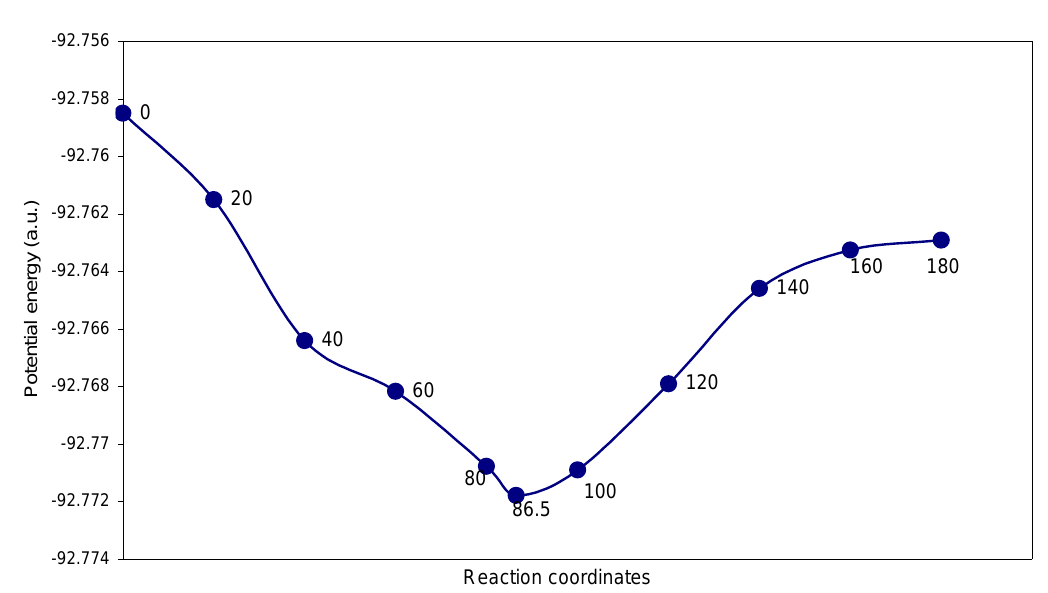
Table 8: the optimized geometric parameters and total energy as a function of torsional angles; The potential energy diagram of the molecule is the Figure 8.